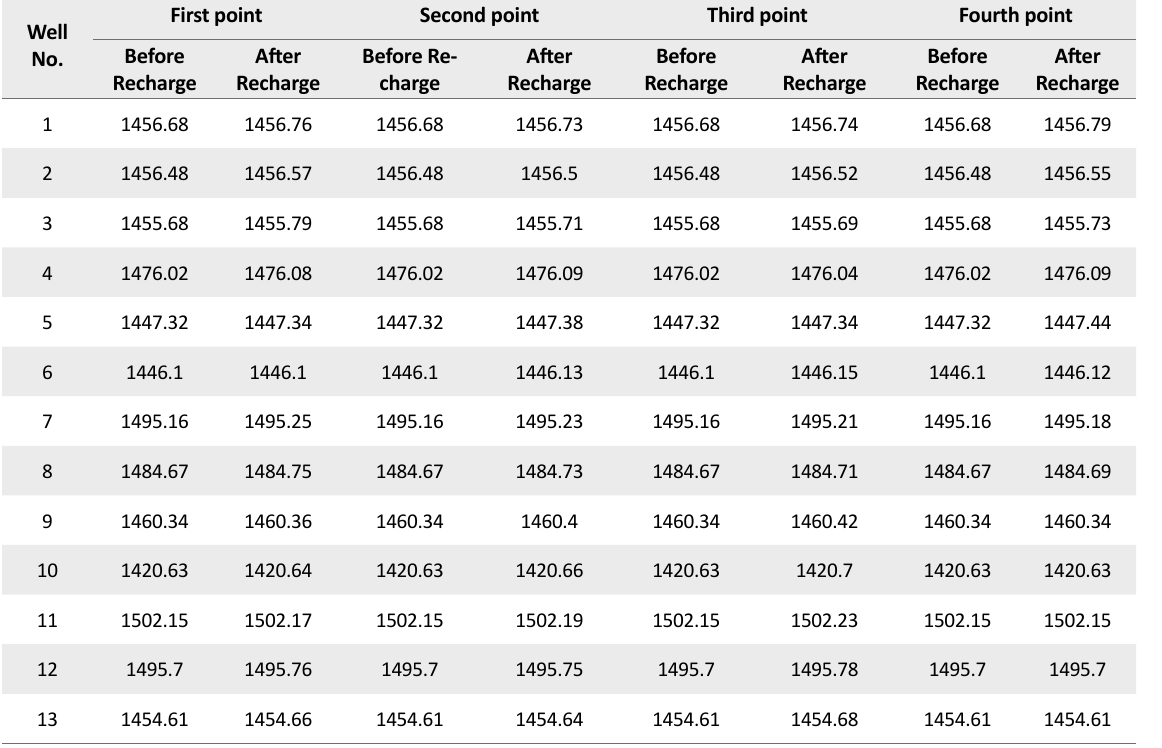
Fourth pointThird pointSecond pointFirst point After RechargeBefore After RechargeBefore Re- After RechargeBefore Recharge Recharge charge